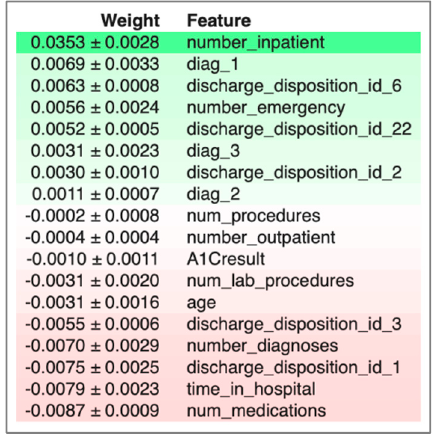
Figure 7. Permutation importance for the stacking